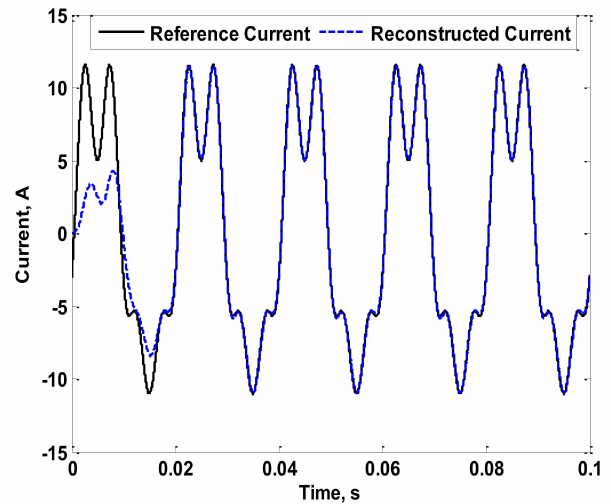
Figure 8. Reference and Reconstructed Currents of the Simulated Coil Considering a Change in the Phase Angle of the Fourth